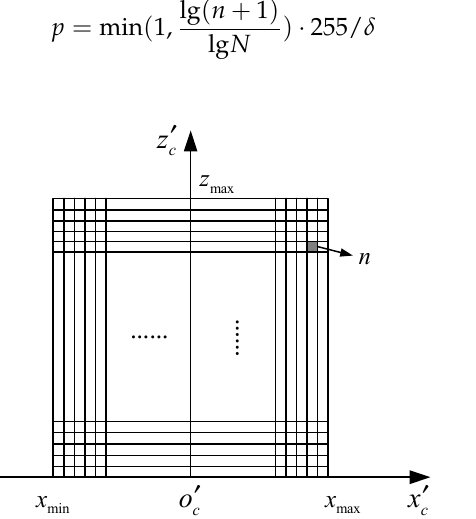
Figure 2. The coordinate system projected to the BEV image plane (a top-down view in the ground plane).